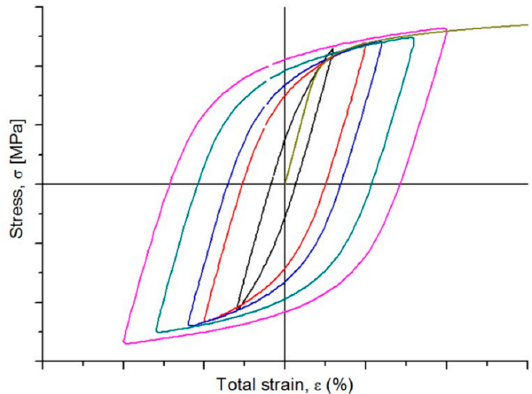
Figure 1. Schematic of the cycle stress–strain curve obtained by hysteresis loop.